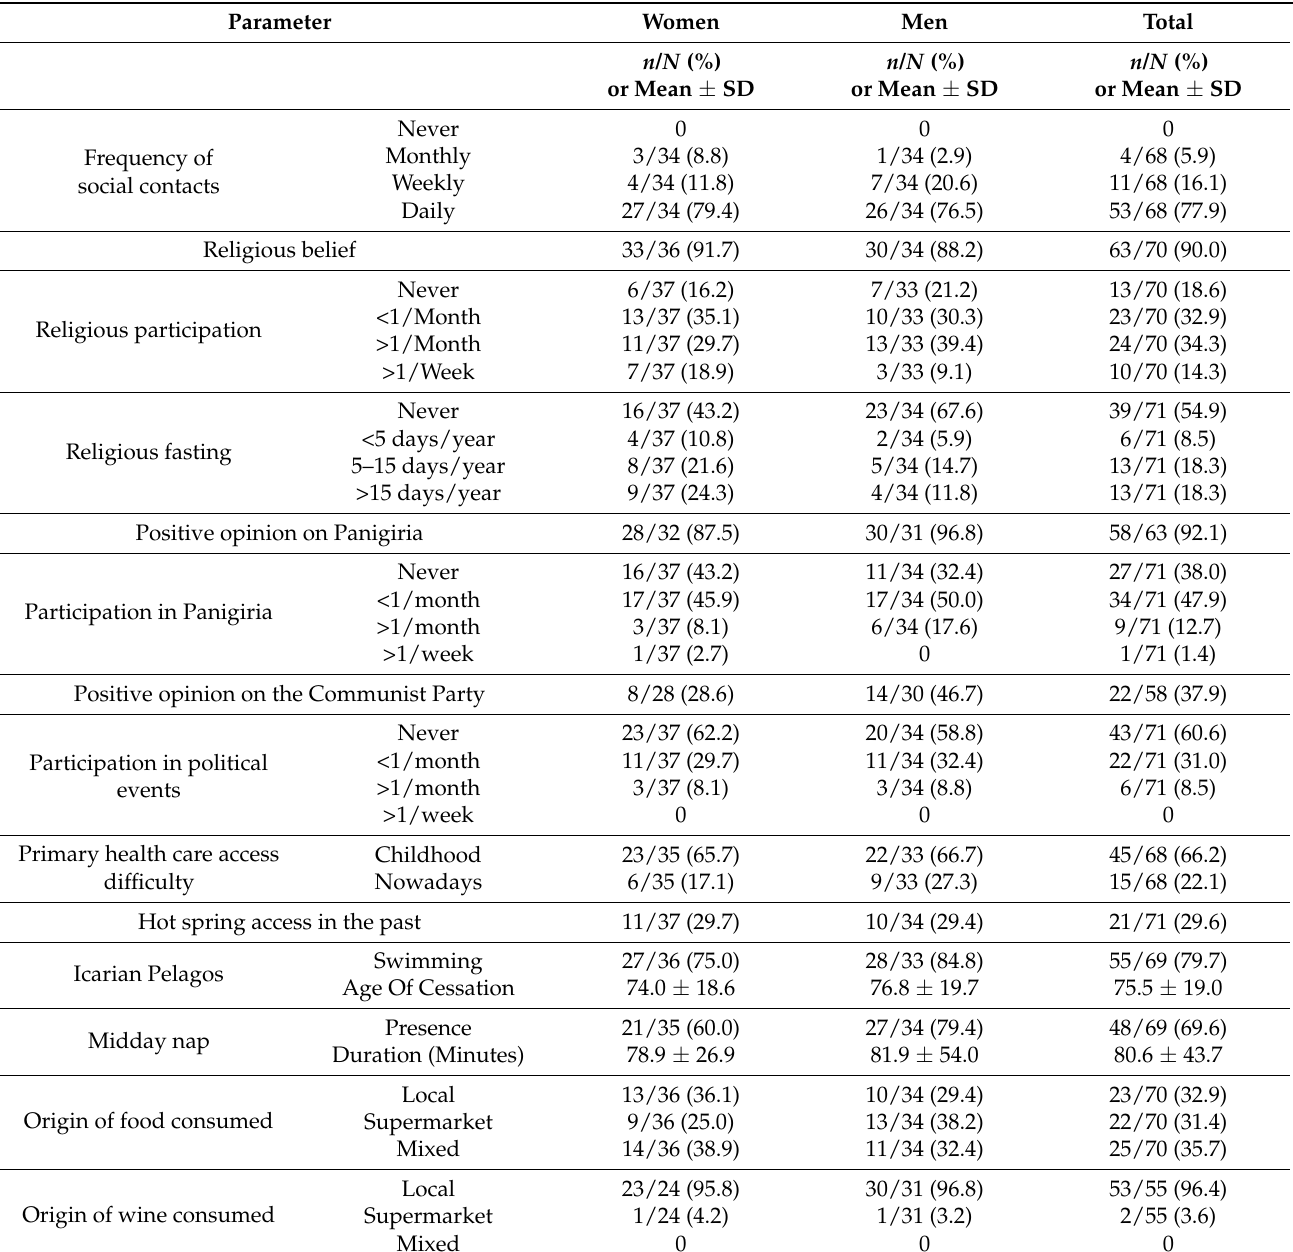
Table 1. Social data of